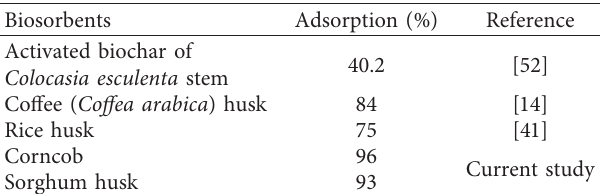
Table 4: Comparison of the adsorption efficiency with literature